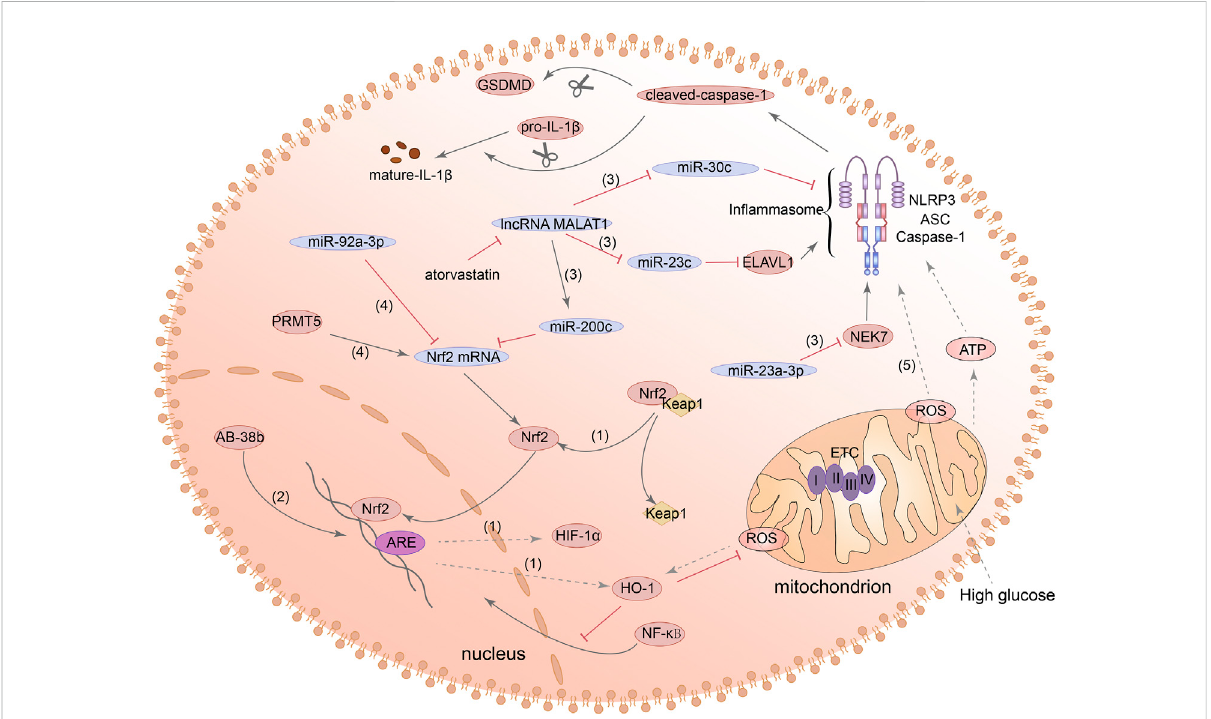
FIGURE 4 Nrf2/HO-1/NLRP3 signaling pathway is involved in the regulation of pyroptosis. (1) Nrf2 can be separated from Keap1 and translocated to the nucleus to activate its downstream target genes such as HO-1 and HIF-1 α . (2) Ab-38b can activate Nrf2 and inhibit NLRP3 expression. (3) lncRNA- MALAT1/miR-200c/Nrf2 signaling pathway, MALAT1/miR-23c/ELAVL1/NLRP3 signaling pathway, MALAT1/miR-30c/NLRP3 signaling pathway and miR-23a-3p/NEK7/NLRP3 signaling pathway, they all can regulate the activation of NLRP3. (4) MiR-92a-3p can inhibit the expression of Nrf2, and PRMT5 can promote the expression of Nrf2. (5) Nrf2 can promote the expression of ROS and ROS can lead to the activation of NLRP3 in fl ammasome and increase the expression of cleaved-caspase-1 and